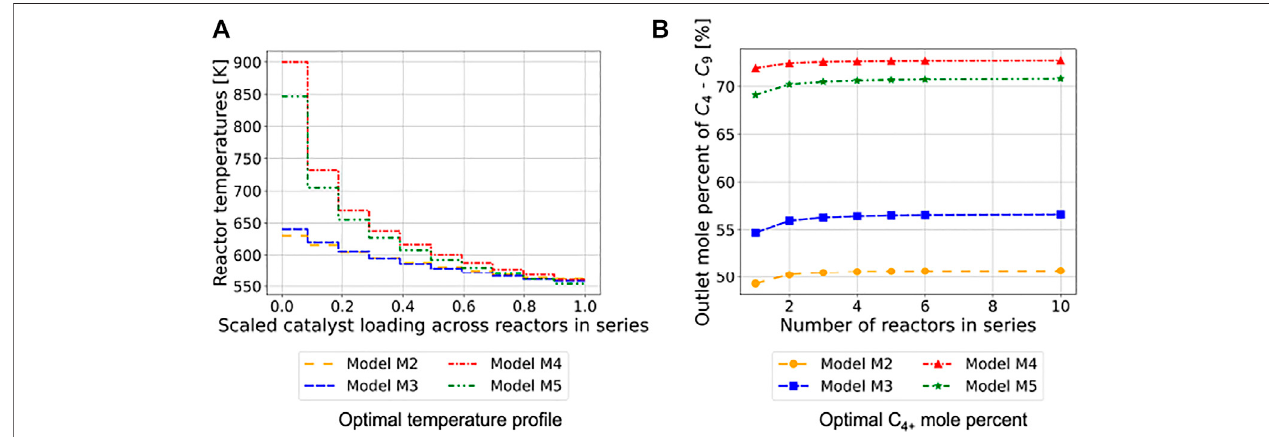
FIGURE9| Optimization results fromthestaged reactordesigncalculationsaimedat maximizingoutlet mole percent ofbutene and heavier ole fi ns (A) The optimal temperaturepro fi leacross10stagedisothermalPBRsformodels M2 to M5 .Eachstepintheplotcorrespondstothetemperatureinastagedreactor.Catalystloadingis directly proportional to the volume of a PBR; the horizontal axis is presented in terms of scaled catalyst loading (similar to pro fi les generated across a PBR) and is indicative of the PBR stages from fi rst to last (B) The optimal outlet mole percent of butene and heavier ole fi ns obtained from the staged reactor calculations by resolving Eq. 28 for one to 6 and 10